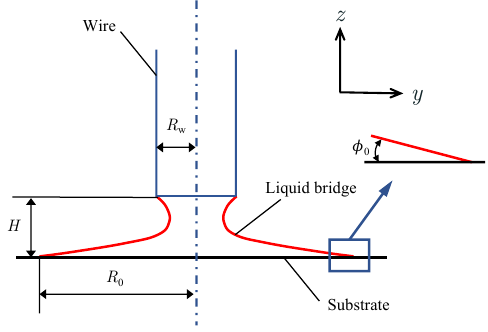
Figure 2. Schematic diagram of the liquid bridge metal transfer